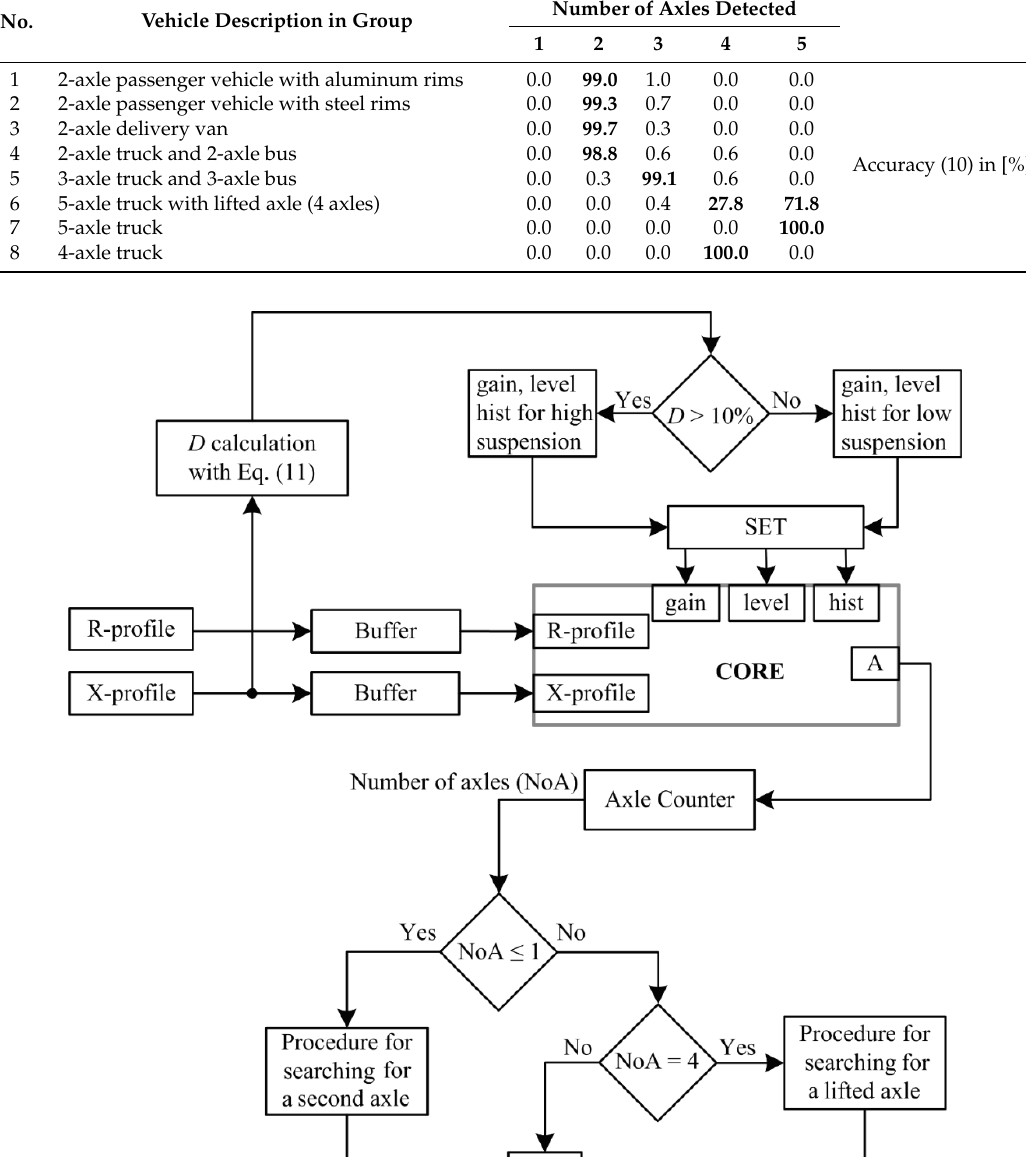
Table 4. Vehicle axle detection accuracy (10) for a set of data from 4000 vehicles, using the algorithm from Figure 8.